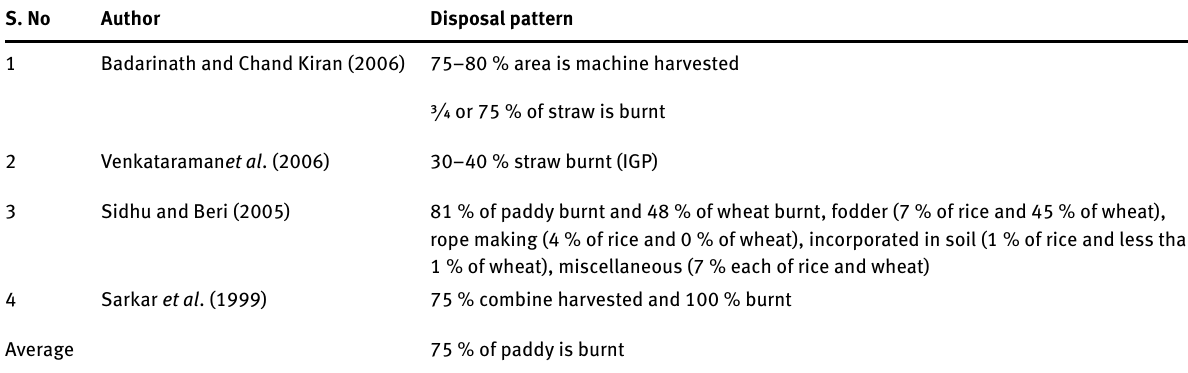
Table 7: End use of paddy straw S.